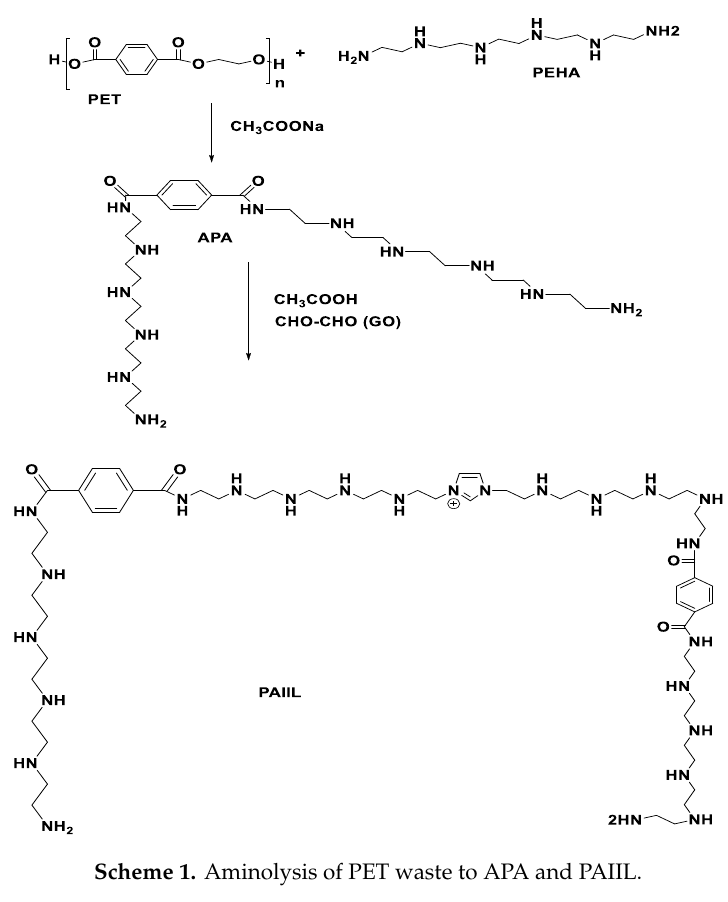
Figure 1. GPC data of ( a ) APA and ( b ) PAIIL.